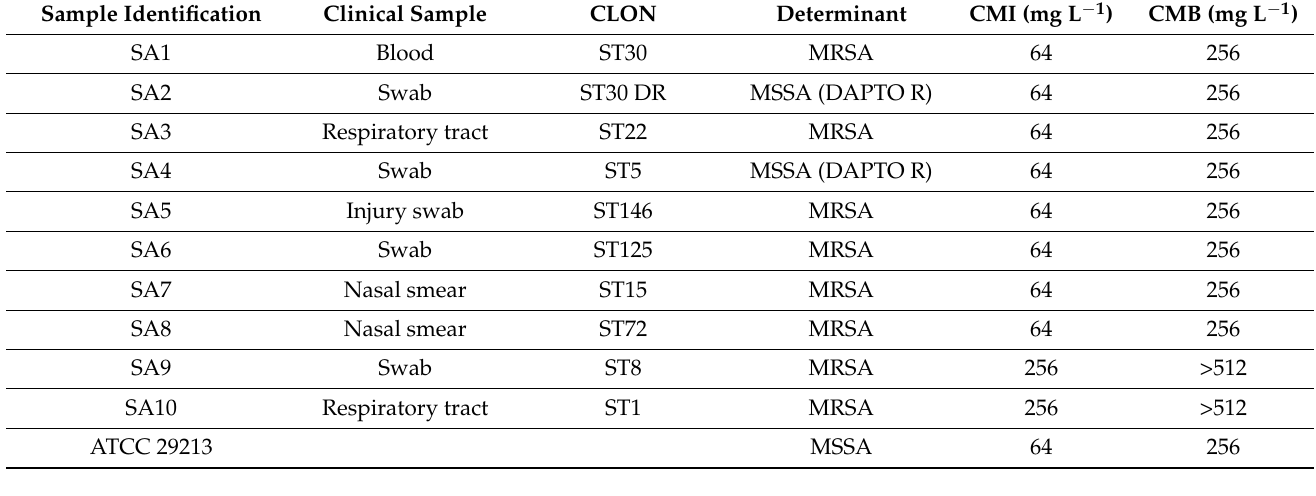
Table 5. Provenance of ten clinically relevant Staphylococcus aureus isolates from different clinical samples at the hospital Virgen Macarena (Sevilla, Spain).